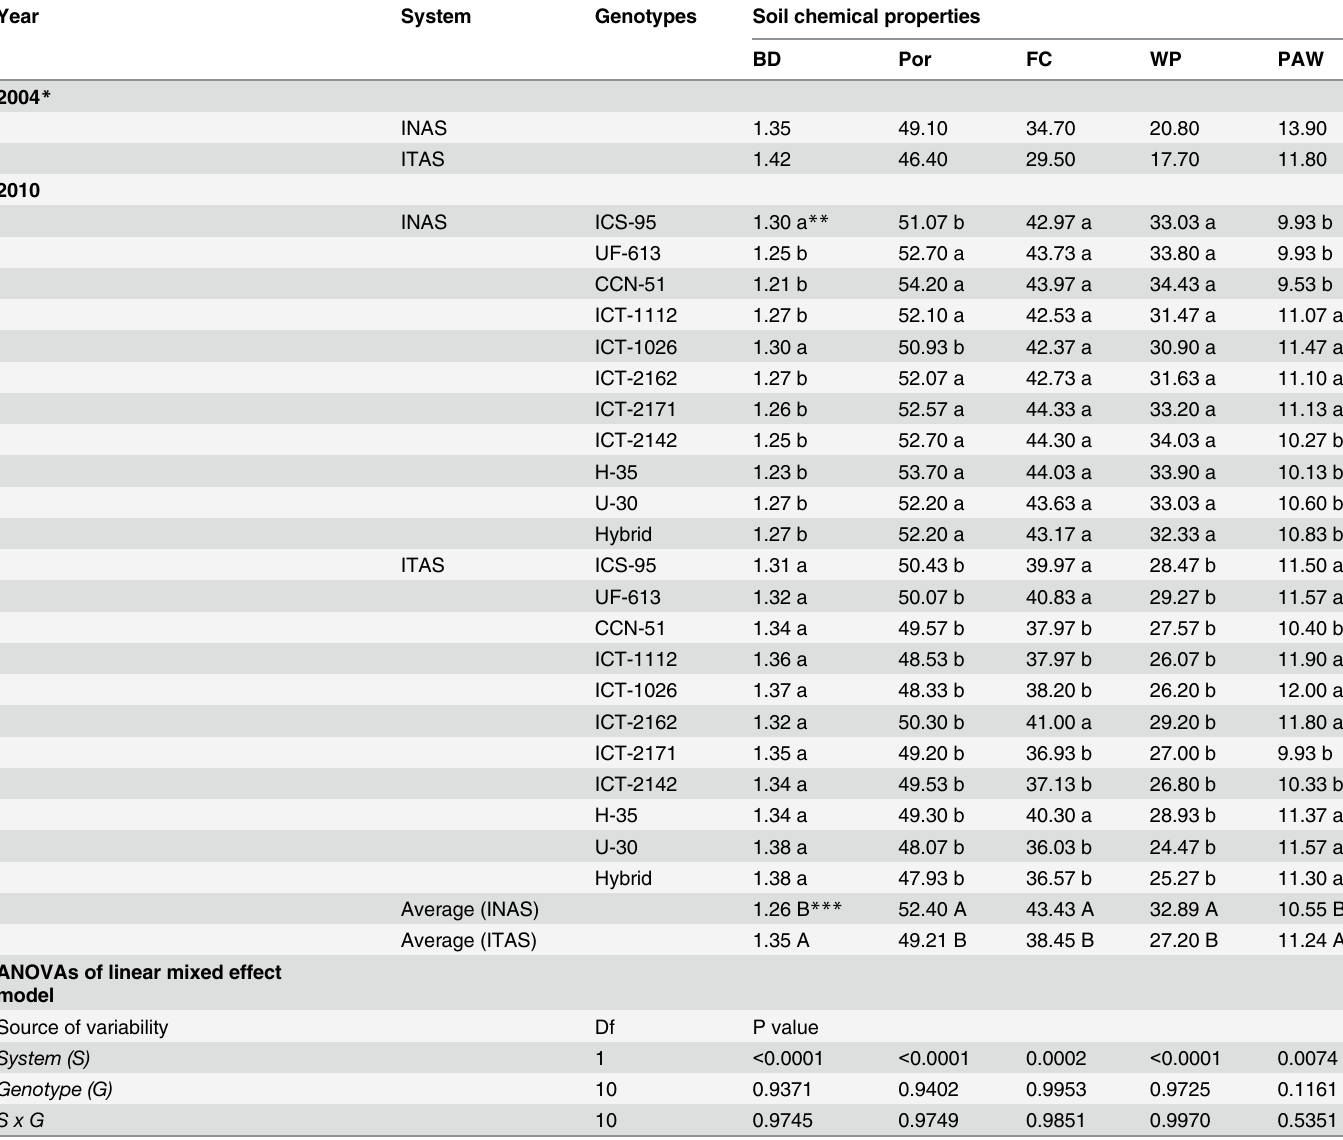
Table 5. Soil Physical Properties: BD, Po, FC, WP, and PAW, for 2010 Influenced by Systems of Cacao Management and Cacao Genotypes at 0- 20cm Depth. Year